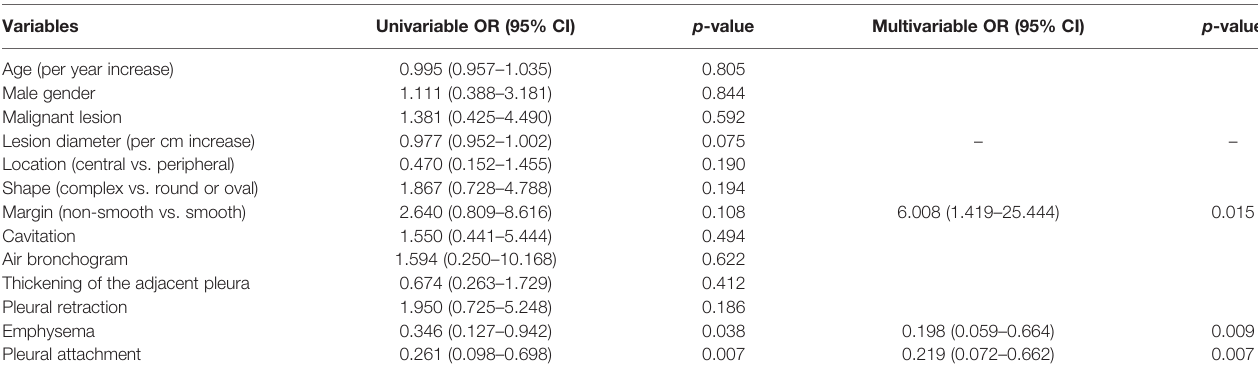
TABLE 5 | Factors associated with signi fi cant inter-modality variation of volume. Variables Univariable OR (95% CI) p -value Multivariable OR (95% CI) p -value Age (per year increase)